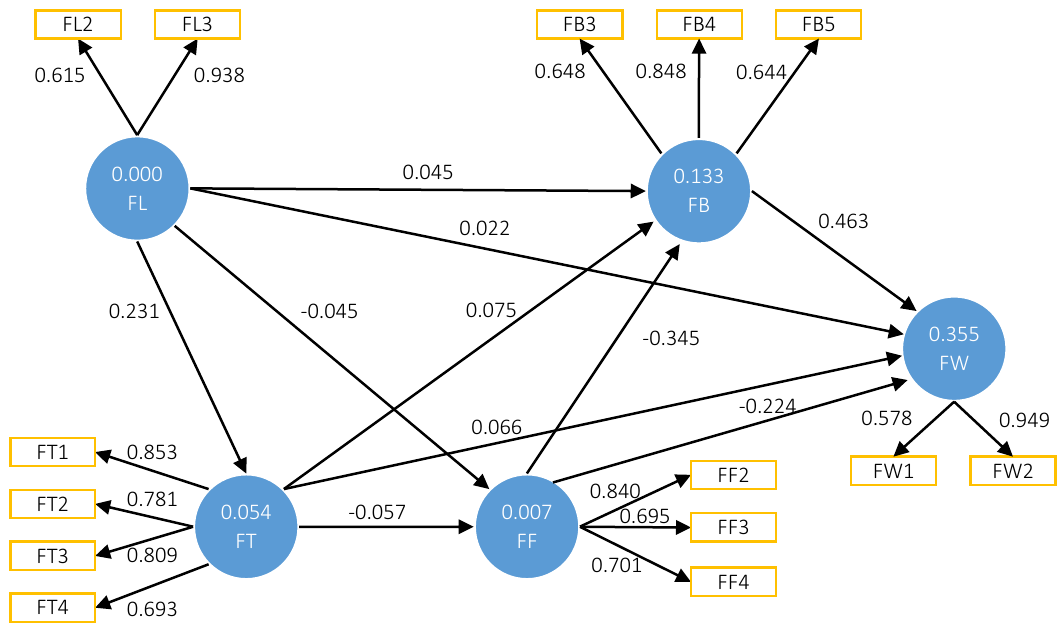
Figure 2. Path coefficients and outer loadings Table 6. Total effects of the